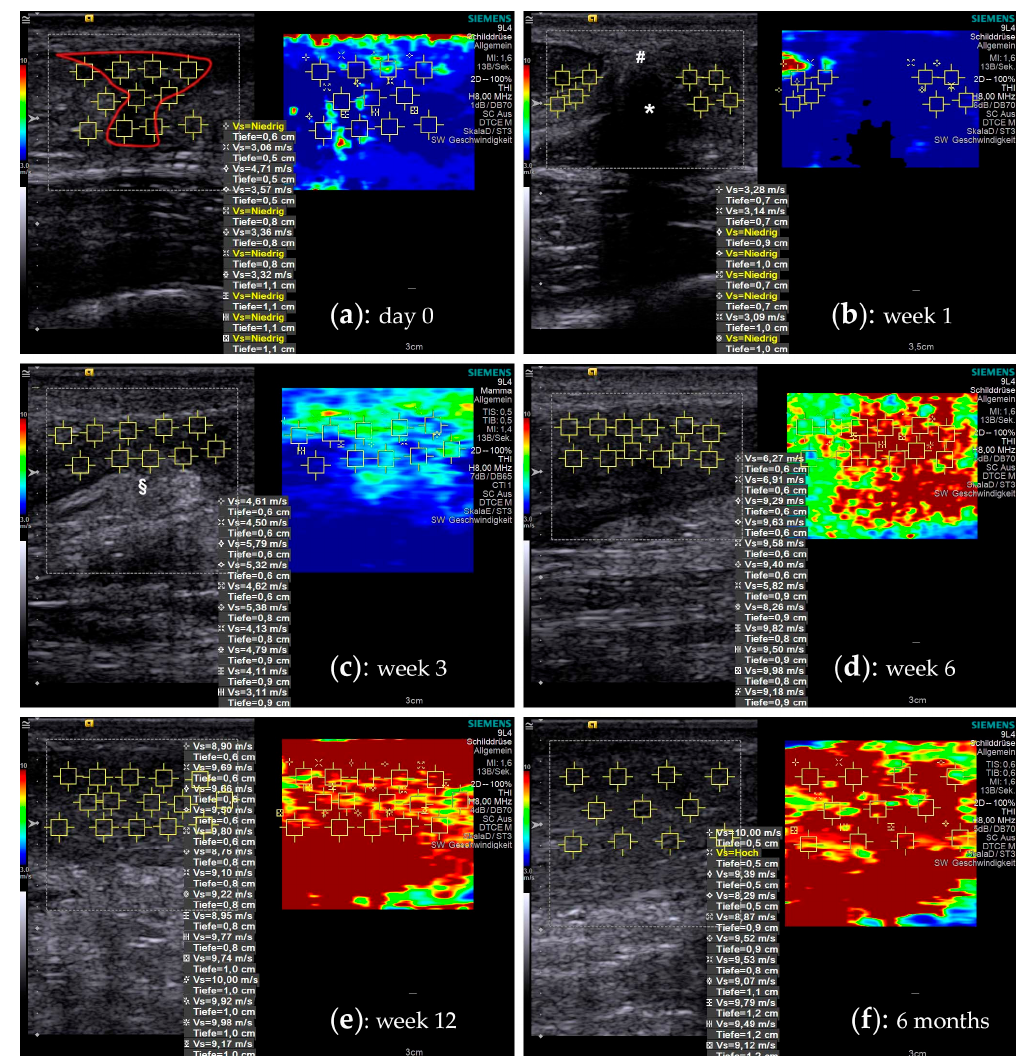
Figure 1. Shear wave elastography images during the course of tendon healing. A split screen view with a B-mode ultrasound image on the left side allows choosing a particular ROI (yellow squares), where the SWV is measured. A corresponding color-coded SWE image on the right side visualizes the elastographic stiffness. ( a ) The figures show a time-course of the rupture area of a 26-year-old male patient that was treated non-operatively: at the time of injury the tendon gap is filled with hematoma (red outline). The tendon stumps are retracted and due to the lack of tension, they show a very low SWV, which often is below the measurement threshold (“Vs = Niedrig”). ( b ) At one week the hematoma is mostly consolidated (#), connecting the remnants of the original tendon substance (* acoustic shadowing). ( c ) At three weeks, the hematoma is resorbed and the primary tendon callus, with partly hyperechoic fibrous tissue (§), starts regaining its biomechanical strength. ( d ) Six weeks into the healing process, the tendon callus has reached a significant increase in elastographic stiffness. ( e ) In the following remodelling phase, the tendon tissue further consolidates, expressing an additional increase (week 12). ( f ) In later phases the measurements often reaches the peak measurement limits of 10 m/s of the ultrasound machine.